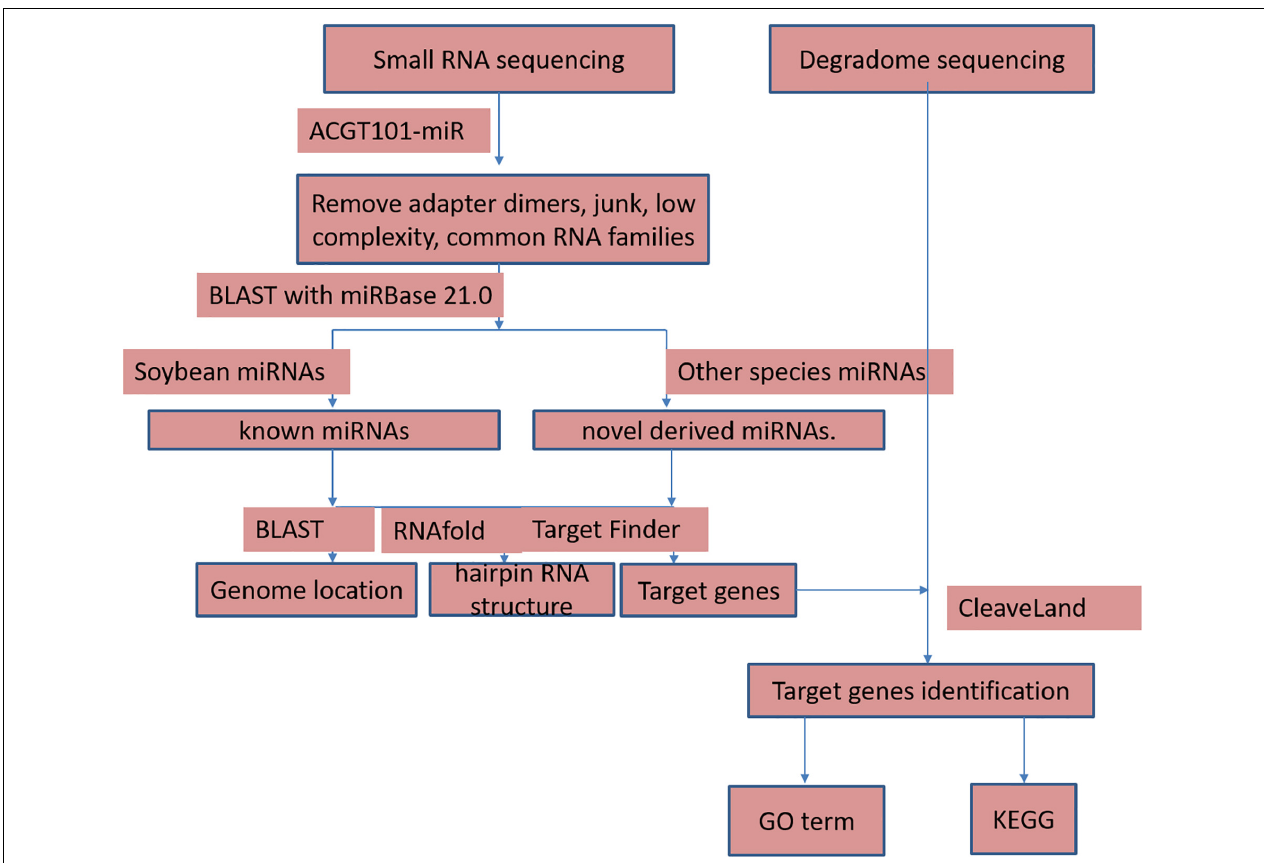
FIGURE 1 | The developmental bioinformatics pipeline of small RNA sequencing analysis in this